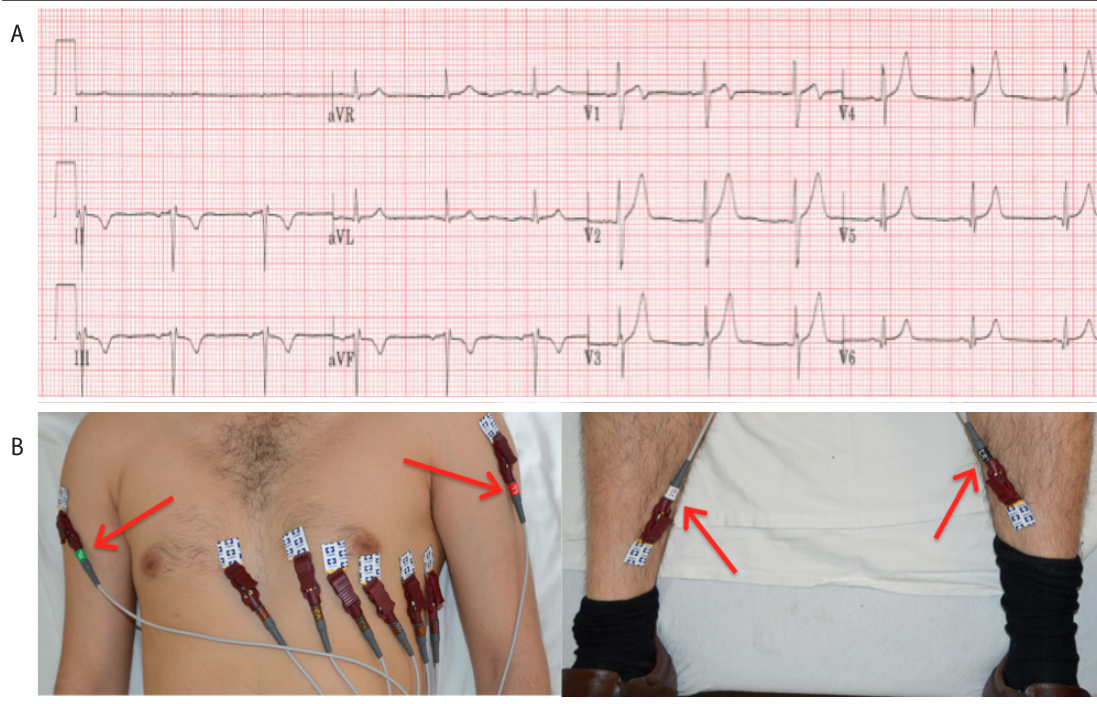
Figure 8. 12 lead ECG depicting dual-lead reversal. (A) ECG recording. (B) Arrows point to reversal of leads on right and left arms and